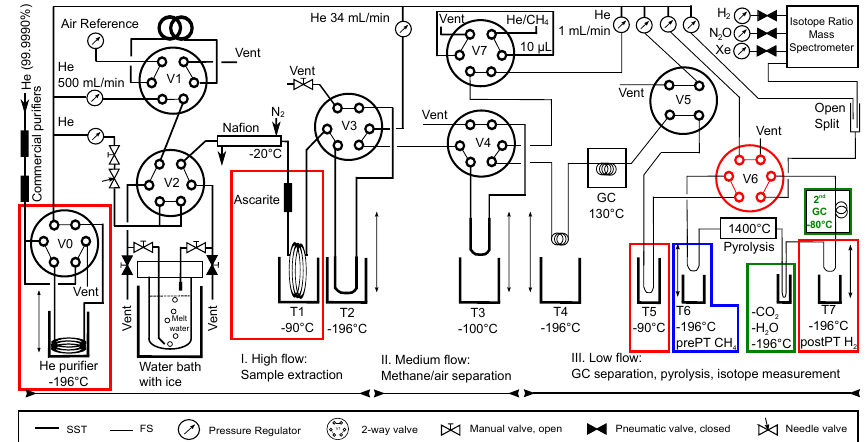
Figure 1. Flow scheme of the new δ D(CH 4 ) system including pre- and post-pyrolysis trapping of methane and hydrogen, respectively, and a second short, cooled chromatographic separation column (2nd GC) after the last trap. The coloured boxes highlight the major differences compared to Bock et al. (2010a). Red are the changes made in 2011–2012, blue represents additional changes carried out in 2013 and green in 2014 (compare Table 1). Capillaries are stainless steel (SST) or fused silica (FS), with the latter occurring only in the low-flow part. Inside the GC we use a Carboxene 1010 PLOT column (30m, i.d.=0.32mm). Cold traps are “He purifier” (charcoal, 1/4in.), T1 (open tube, 1/8in.), T2 (charcoal, 1/4in.), T3 (Hayesep D, 1/8in.), T4 (CP-PoraBond Q, i.d.=0.32 mm), T5 (open untreated capillary, i.d.=0.53mm), T6, T7 and 2nd GC (all GS-CarbonPLOT, i.d.=0.32mm). The CO 2 and H 2 O trap after the pyrolysis oven consists of a piece of untreated capillary (i.d. 0.32mm) immersed in